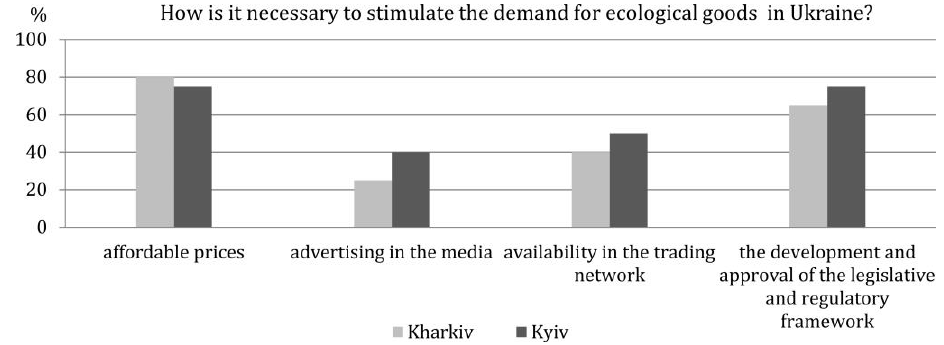
Fig. 11. Preferred directions for the stimulation of demand for ecological goods (Source: author's research)